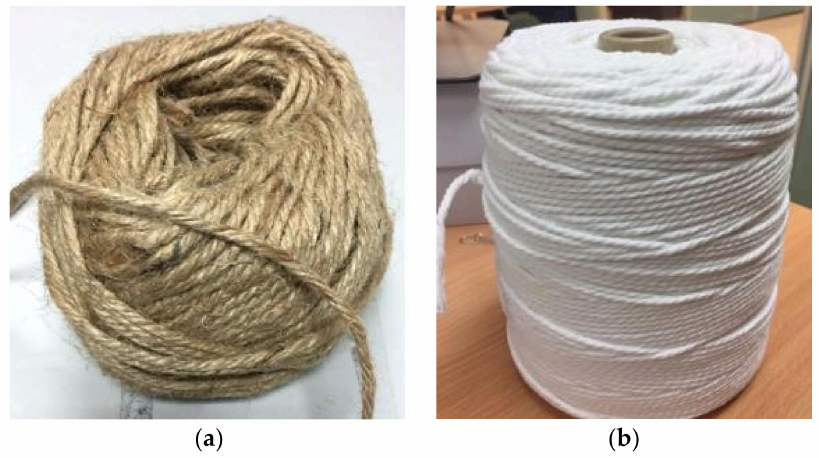
Figure 2. Natural fiber ropes ( a ) hemp and ( b ) cotton.